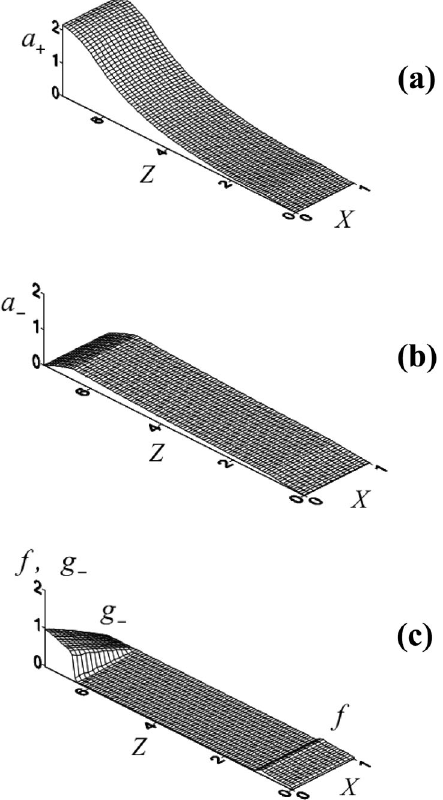
FIG. 9. Spatialdistributions ofpartial wavebeams in thesteady- state regime for the same parameters as in Fig. 8: (a),(b), the propagating wave amplitudes a (cid:4) ð Z; X Þ , (c) the cutoff mode f ð Z; X Þ in the upstream advanced Bragg reflector and one of the ‘‘transverse synchronization’’ waves g (cid:2) ð Z; X Þ in the downstream 2D Bragg